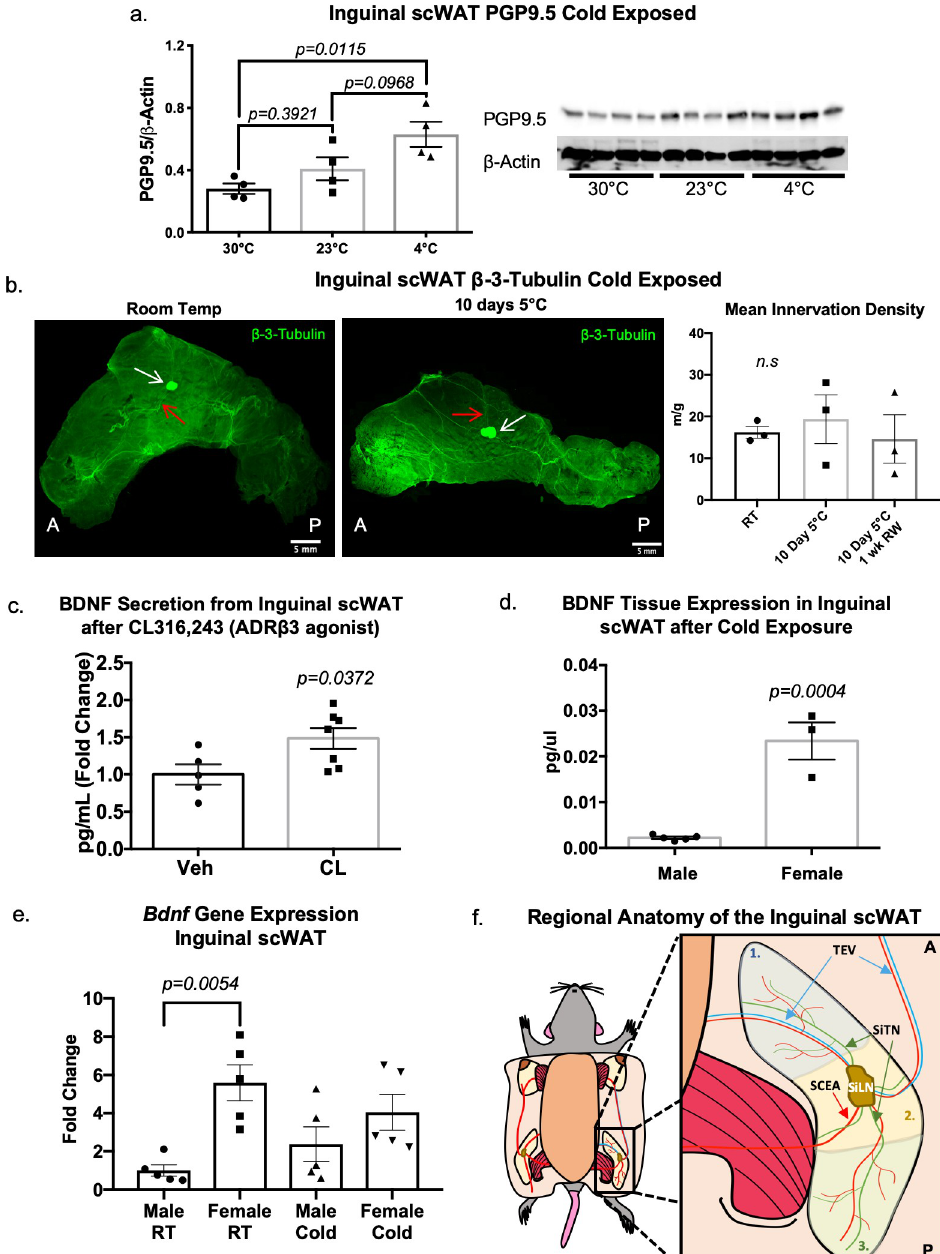
Fig 7. Cold exposure induces adipose nerve remodeling. Adult (8 week old) wild-type C57BL/6J male mice were either cold exposed (at 4˚C), maintained at room temperature, or at thermoneutrality (30˚C) for 3 days. Changes in innervation were assessed by measuring protein expression of a pan-neuronal marker (PGP9.5) in inguinal scWAT via western blotting (a). Protein expression was normalized to β -Actin, band intensity was quantified in Image J and analyzed by two-tailed Student’s t-test; N = 4 per group. In a separate experiment, adult (18–22 week old) control male mice on a mixed genetic background were maintained either at room temperature (RT), at 5˚C for 10 days, or at 5˚C for 10 days and then returned to RT for 1 week (rewarmed). Entire depots were immunostained with β 3-Tubuilin and imaged on a Leica TCS SP8 or DMI6000 confocal microscope by tiling z-stacks through the entire depth of tissue (b). For quantification of arborization (b, right panel), tiles were individually Z-projected, background subtracted, thresholded into binary images, and skeletonized. Branches less than 4 μ m in length were excluded from the analysis. White arrows point to subiliac lymph node, red arrows indicate branches of the thoracoepigastric vein (TEV); anterior side (A) is left of subiliac lymph node, posterior side (P) is right of subiliac lymph node. Images are representative of N = 3 per group, error bars are SEMs. Adult (12–13 weeks old) male C57BL/6J mice received either daily i.p.